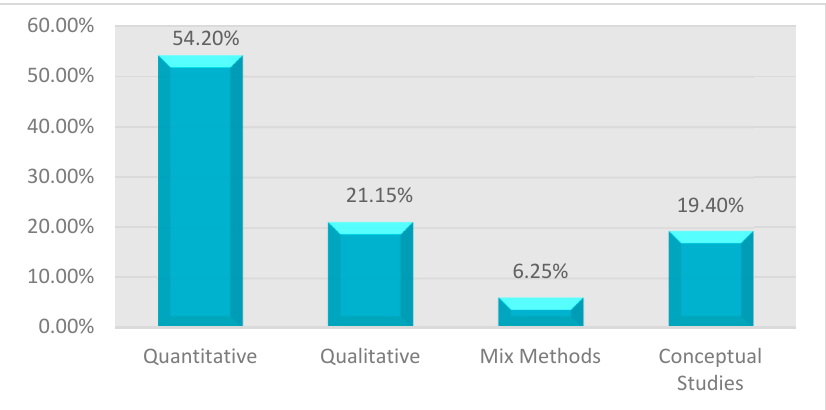
Figure 3. Distribution of research approaches (2011–2020).